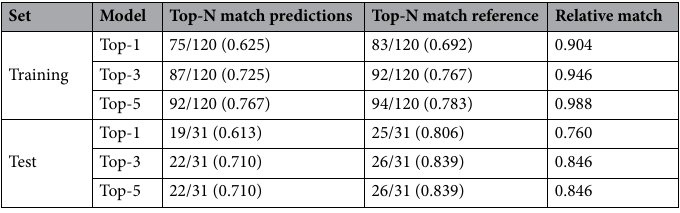
Table 2. Patient-level aggregation results: from the highest scoring predictions, a match is counted if the predicted value matches a value in the adjudicated reference data (top-N match).